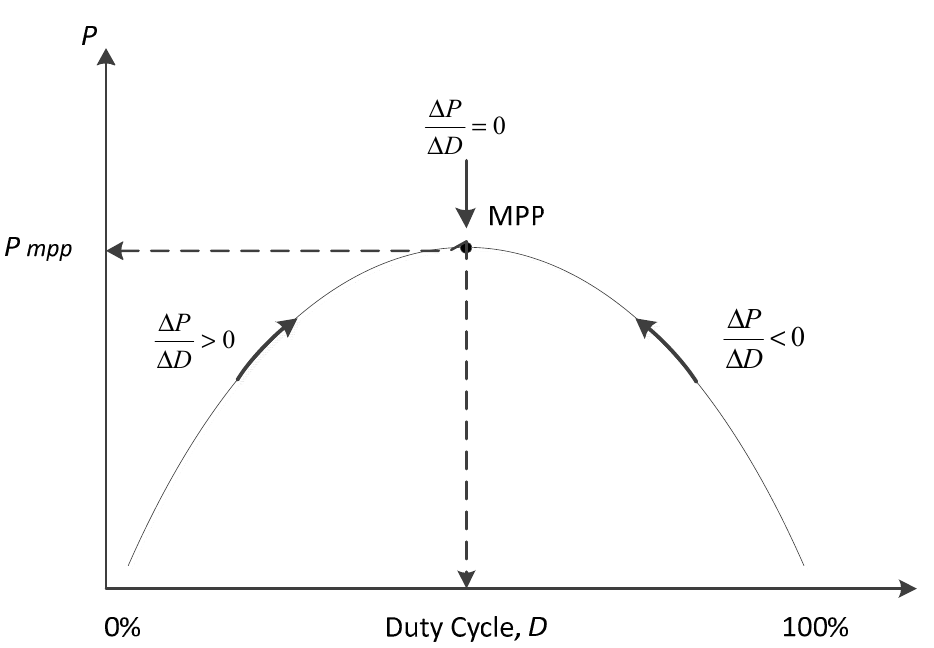
Figure 7. Flow diagram of HC.